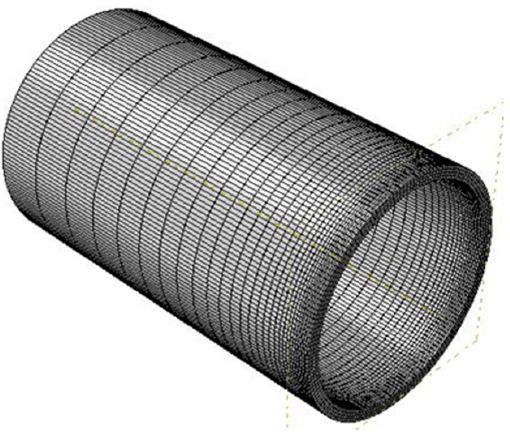
Figure 8. Meshing model of a pipe.